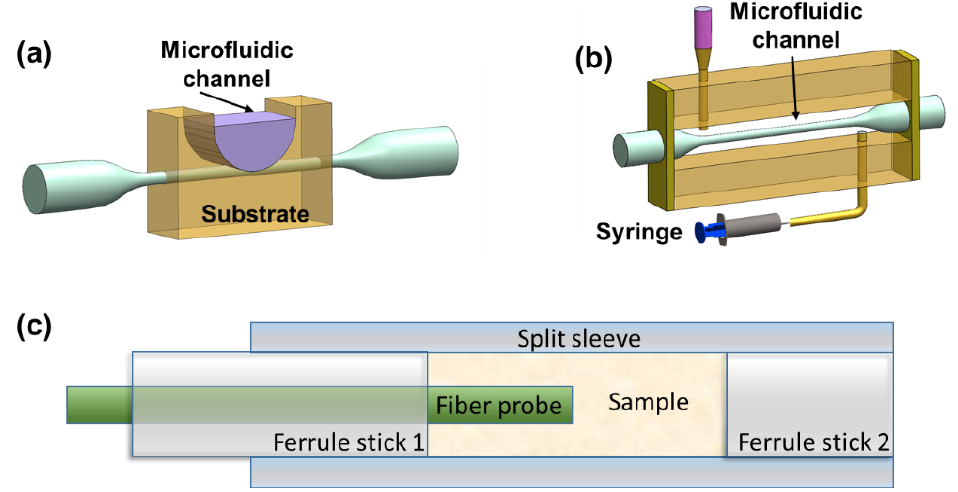
Figure 8. Schematic diagrams of fiber sensor package. ( a , b ) optical fiber integration to microfluidic channel for sensing; ( c ) optical fiber probe for sensing.